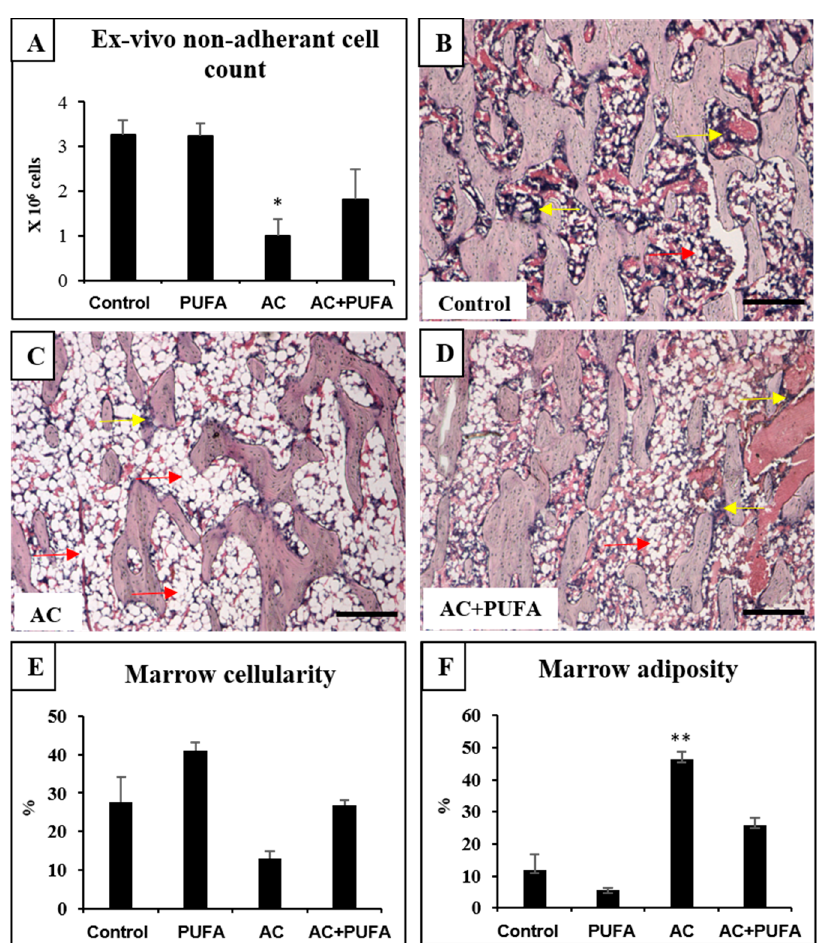
Figure 2. Effects of daily omega-3 polyunsaturated fatty acid (PUFA) supplementation during weekly AC treatment on bone marrow constitution. Treatment effects on counts of bone marrow non-adherent cells isolated from treated rats ( A ); Haematoxylin and eosin (H&E)-stained sections of the lower secondary spongiosa region of the tibia from a control rat ( B ); an AC-treated rat ( C ) and an AC + PUFA-treated rat ( D ); with yellow arrows pointing to non-fat cell bone marrow cells, red arrows pointing to adipocytes. Scale bar on all panels = 200 µm. Treatment effects on the marrow cellularity (%) ( E ) and marrow adiposity % ( F ). Significant values are indicated as: * p < 0.05 and ** p < 0.01 compared to control.